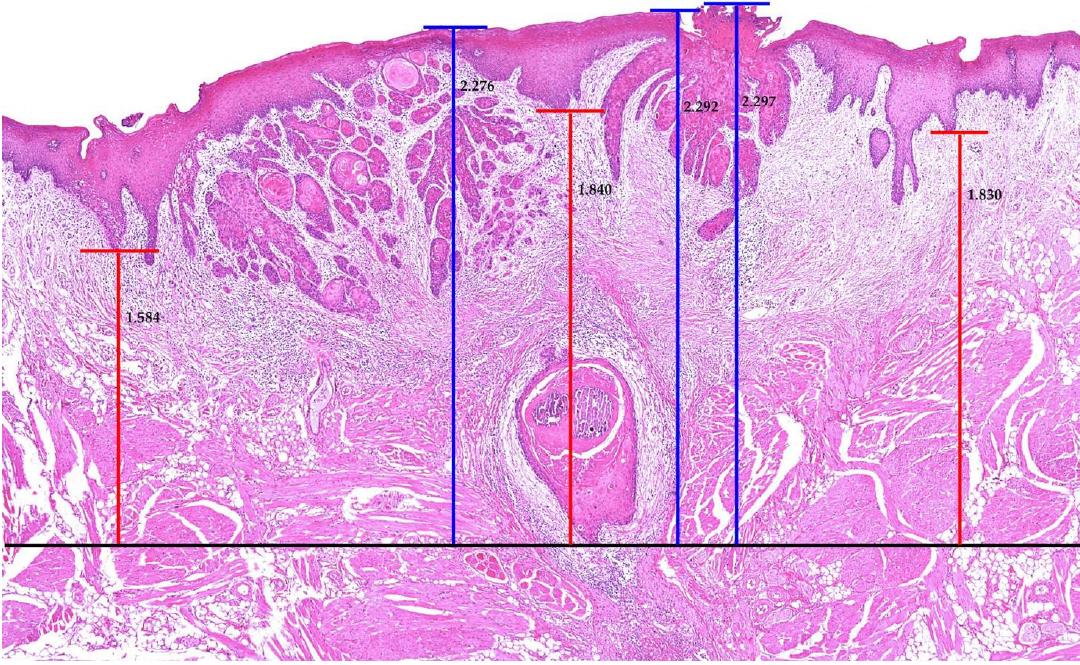
Figure 1. Measurement of depth of invasion (DOI) and tumor thickness (TT), using iSolution Lite software (2003 – 2015, IMT i-solution Inc., Vancouver, BC, Canada). Measuring was repeated three times for each slide, and the mean value was used as the final value. (×40, Blue line; tumor thickness, Red line; depth of invasion).